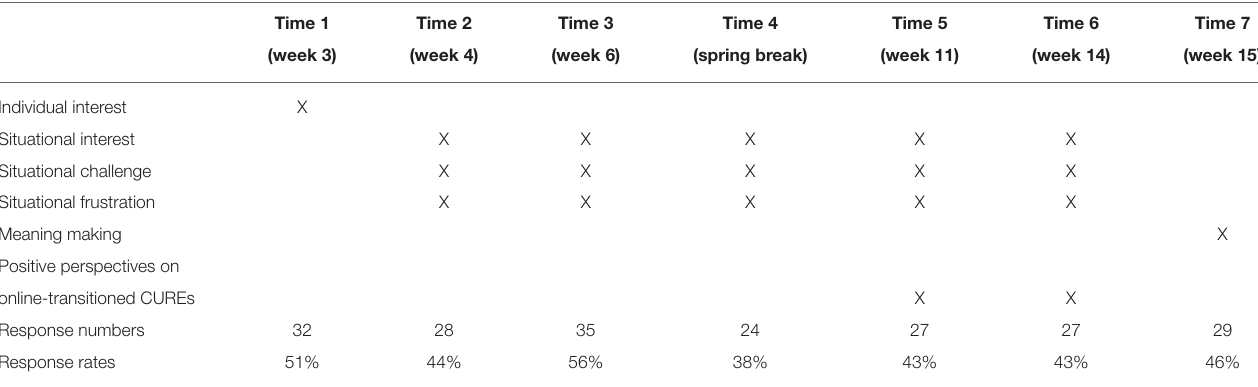
TABLE 1 | Overview of data